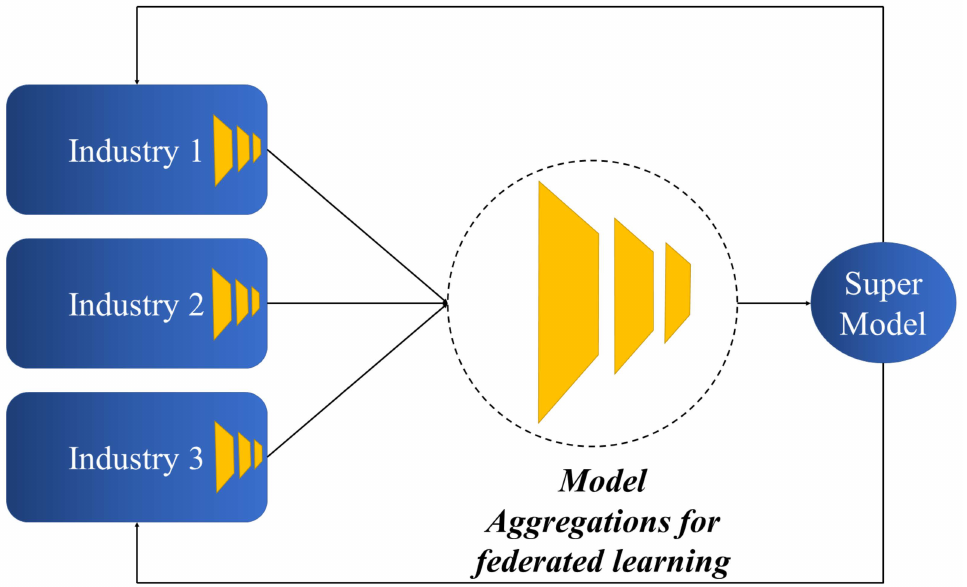
Figure 15. General federated learning